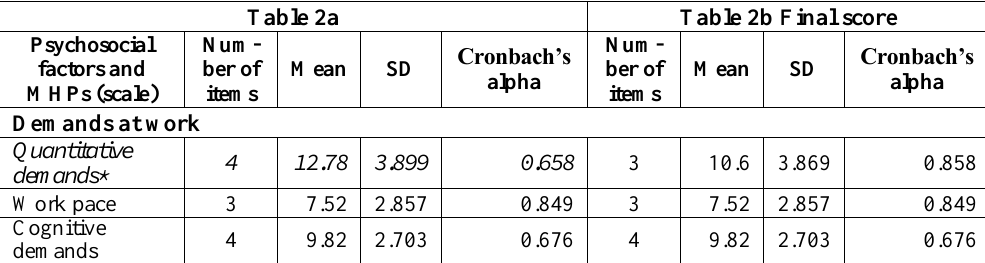
Table 2. Number of item means, standard deviation and Cronbach’s alphas